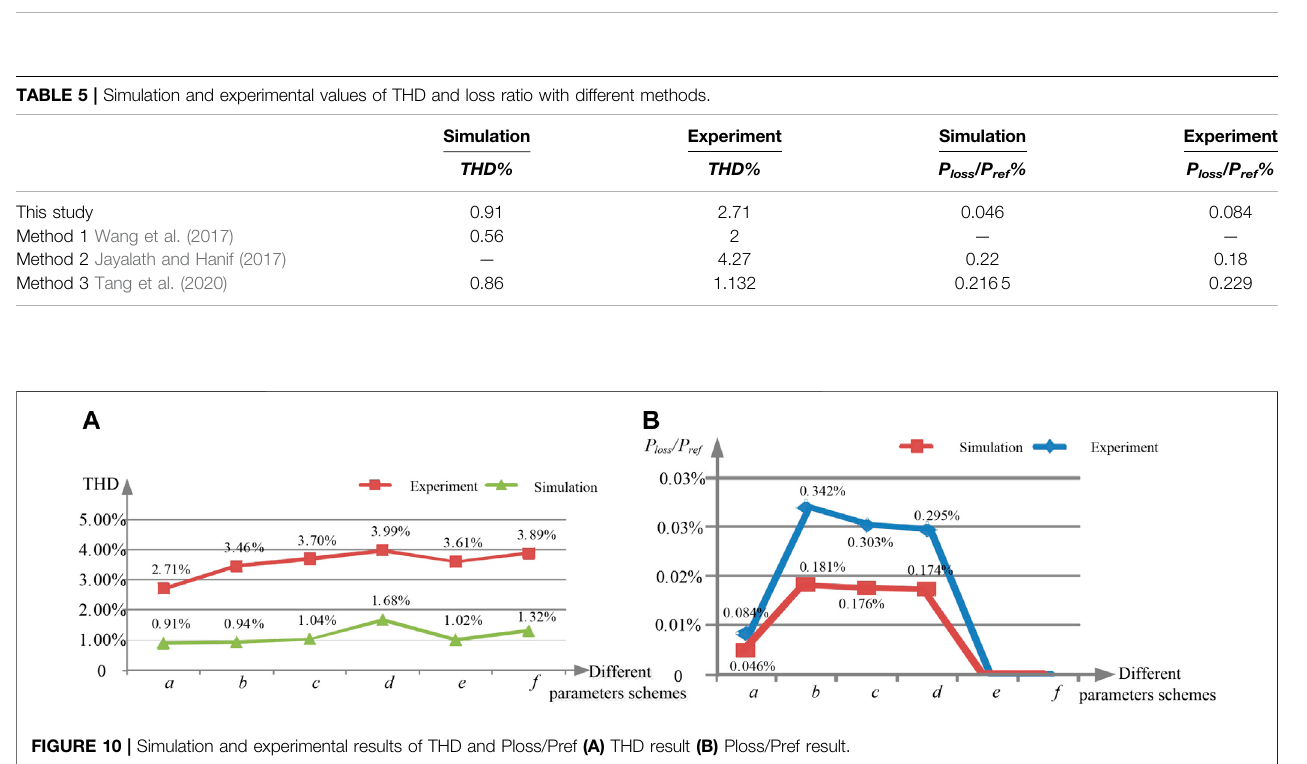
FIGURE 10 | Simulation and experimental results of THD and Ploss/Pref (A) THD result (B) Ploss/Pref